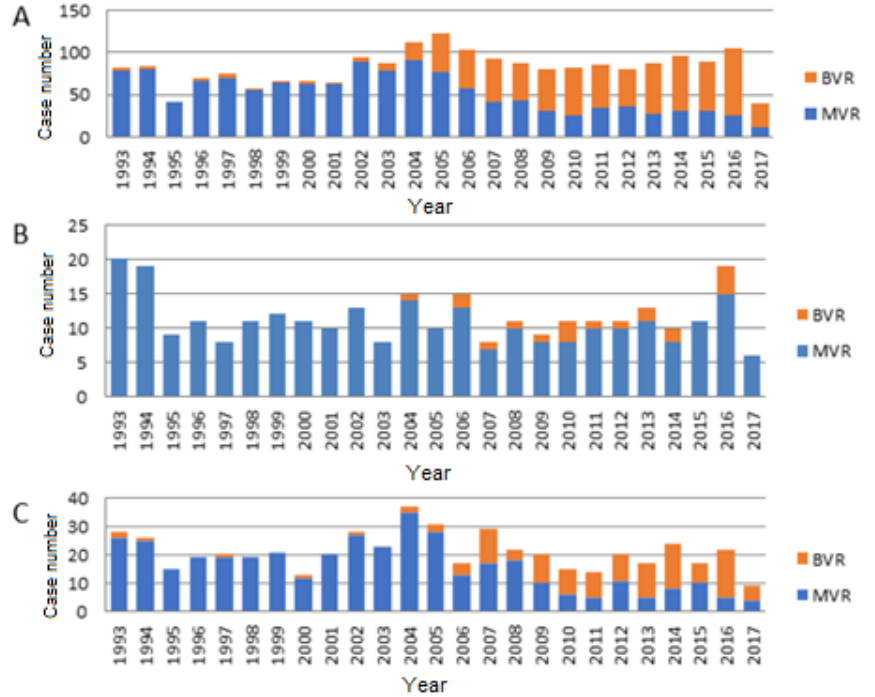
Figure 1. ( A ) The use of mechanical and biological valves in the whole cohort. Until 2003, the trend for the use of biological valves was consistently low. In 2004, its number slightly raised and after the change in guidelines the tendency is changed in favour of more than 50% usage of biological prosthesis per year. ( B ) Distribution of biological and mechanical valve implantations in patients between 50 and 59 years. Biological valves are used in a small percentage of patients undergoing mitral surgery in this age group. ( C ) Distribution of biological and mechanical valve implantations in patients between 60 and 69 years. The use of biological prosthesis started in the early 1990s, but there was about 10 years of non-favourisation. After the change in guidelines in 2006, more than half of the implanted valves were biological in this patient population. BVR= biological valve replacement; MVR= mechanical valve replacement.